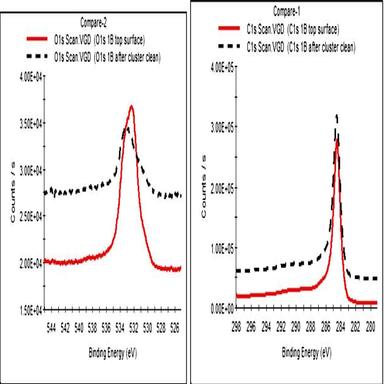
13a. O1s spectra on top and after clean 2A ; 13b. C1s spectra of 2A before and after sputtering.